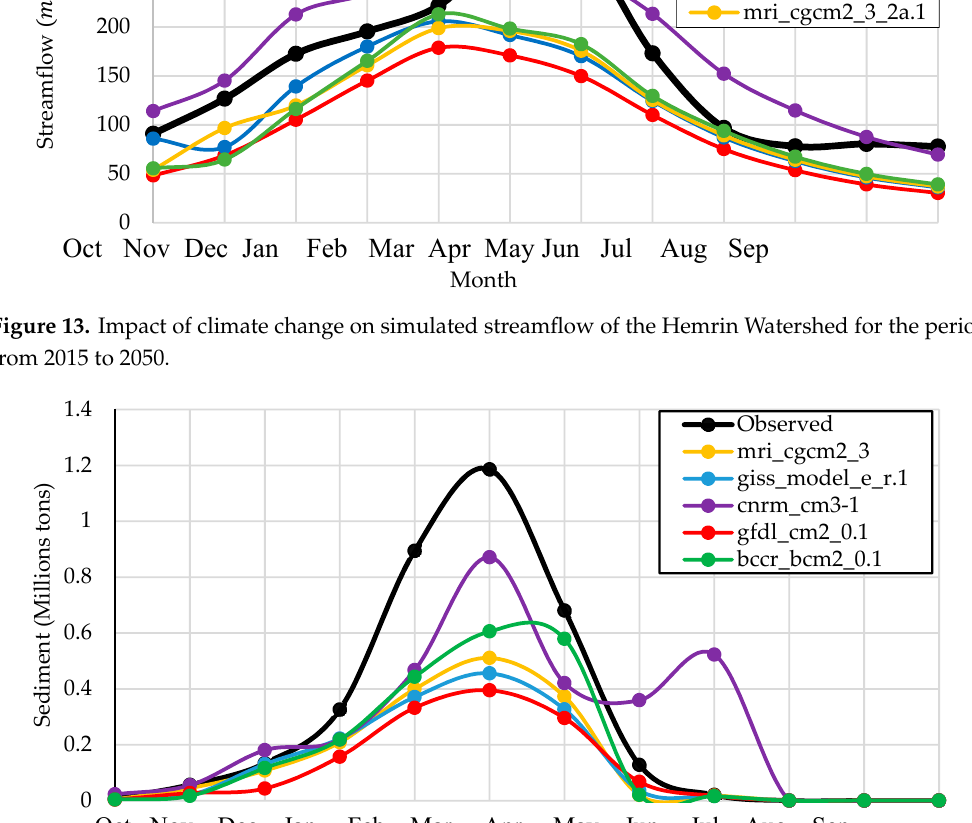
Figure 13. Impact of climate change on simulated streamflow of the Hemrin Watershed for the period from 2015 to 2050.